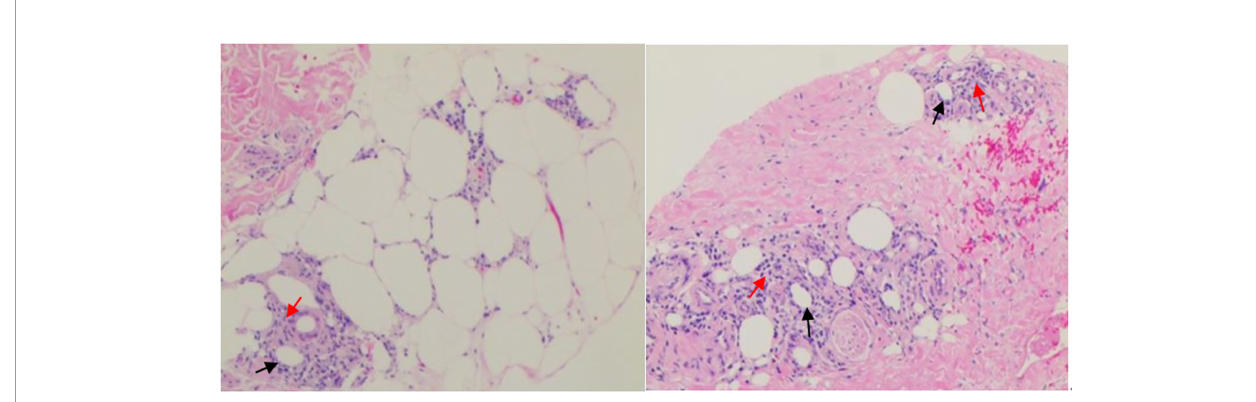
FIGURE 1 | Biopsy specimens of cutaneous tubercle of the right tibia. Photograph showing local degeneration and necrosis of subcutaneous fat( ↑ ), revealing lymphocytic in fi ltration( ↑ ) with irregular nuclear morphology and nuclear rupture in the fat lobules, being in line with changes in nodular panniculitis. Speci fi c stain: Periodic Acid Schiff Diastase (PAS-D) (-), Alcian blue (AB) (-). Direct immuno fl uorescence assay: IgG, C3, IgM, IgA (-).